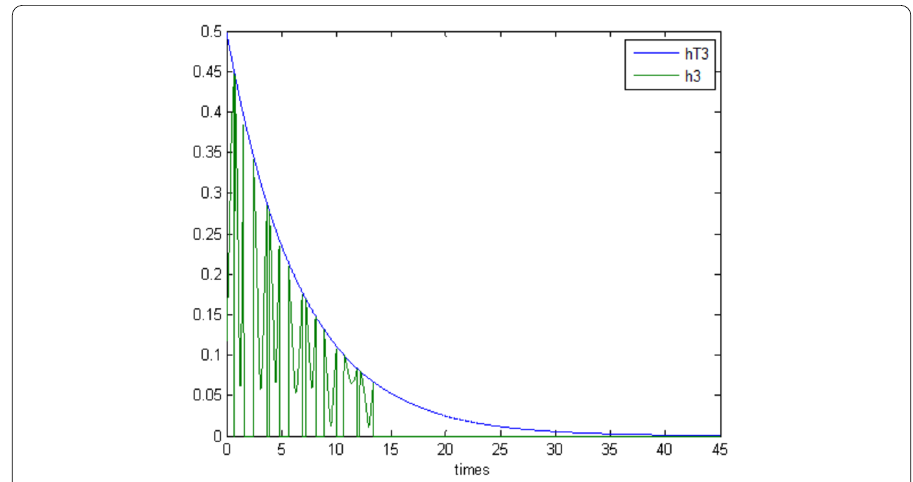
Figure 7 Measurement error of agent x 3